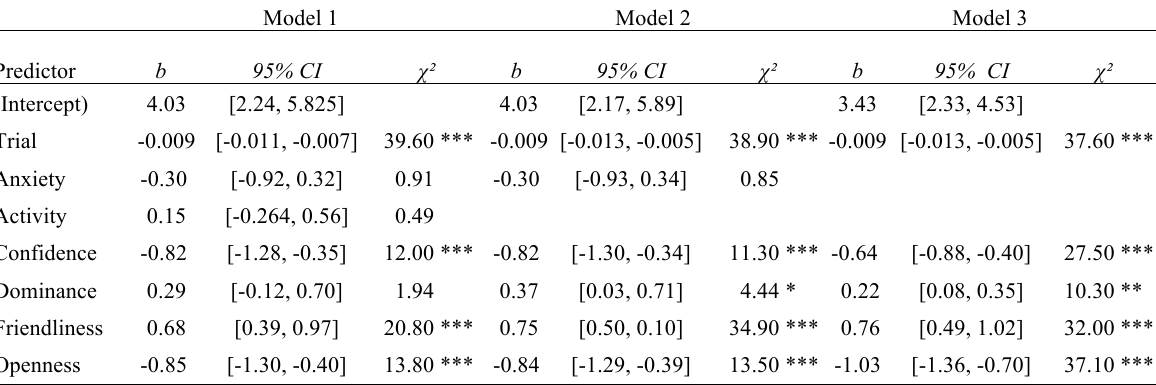
Details of Linear Regression Models of Interest, Predicting RTs on Correct Trials Model 1 Model